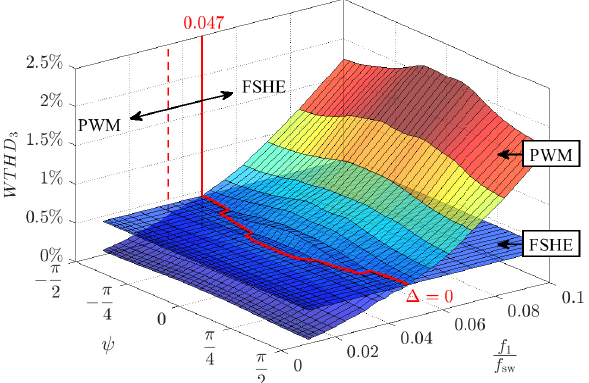
Figure 9. WTHD 3 boundary between multilevel PWM and FSHE for a seven-level inverter operated at a modulation index M =